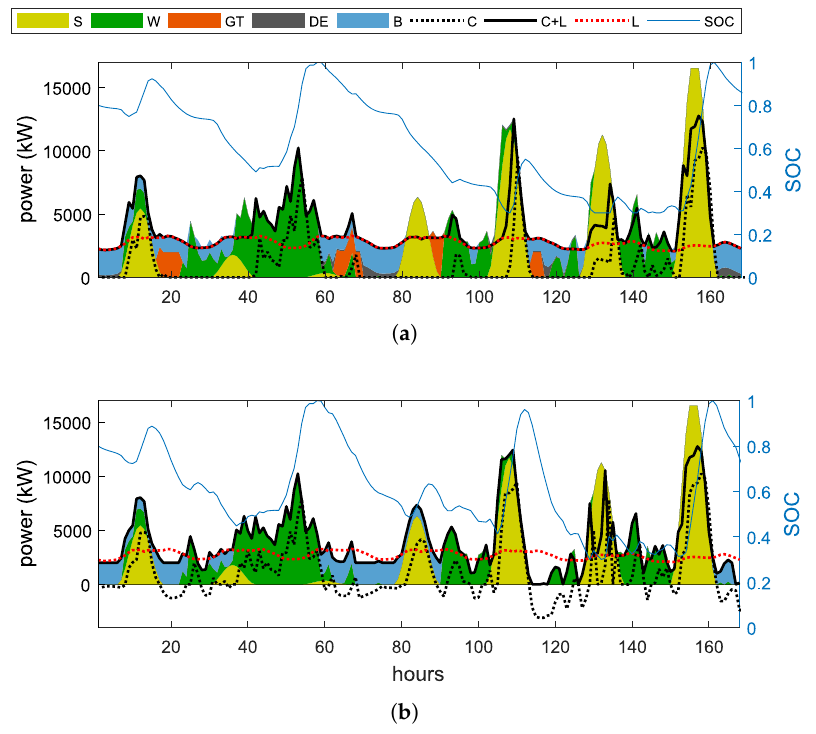
Figure 9. Example of SOC, charge (C), load (L) and generation from gas (GT), diesel (DE), biomass (B), solar (S) and wind (W): ( a ) Without V2G; and ( b ) With V2G. V2G discharge (negative charge) allows avoiding gas turbine and diesel generator